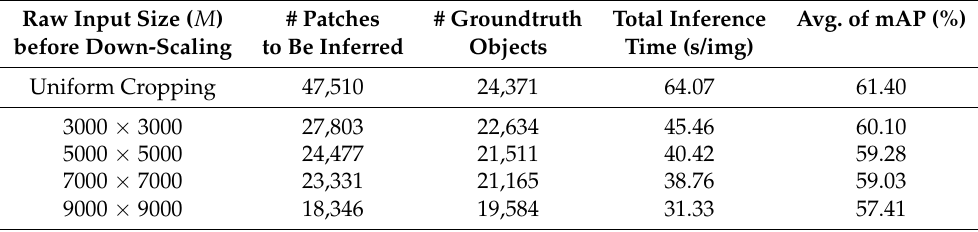
Table 1. Three types of sensitivity analyses for clustering-guided cropping strategy on WorldView-3 test dataset. We exploit RPN of Feature Pyramid Network [26] for all experiments. The symbol # denotes the number sign.